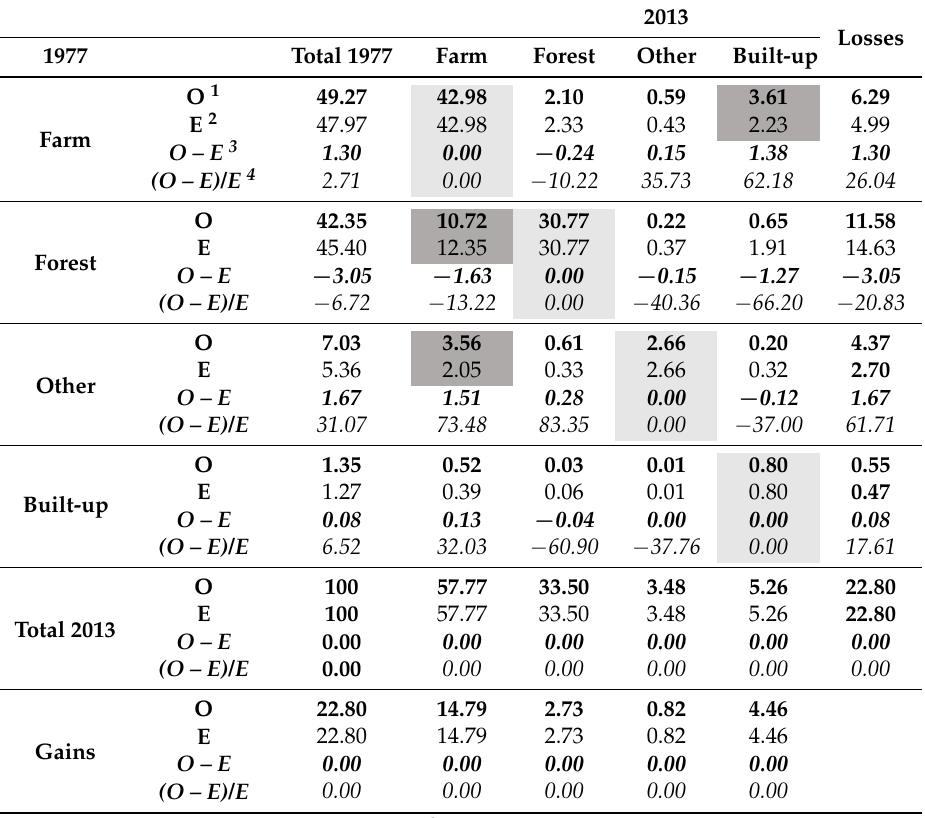
Table 1. Land-use changes over time with estimated gains for each